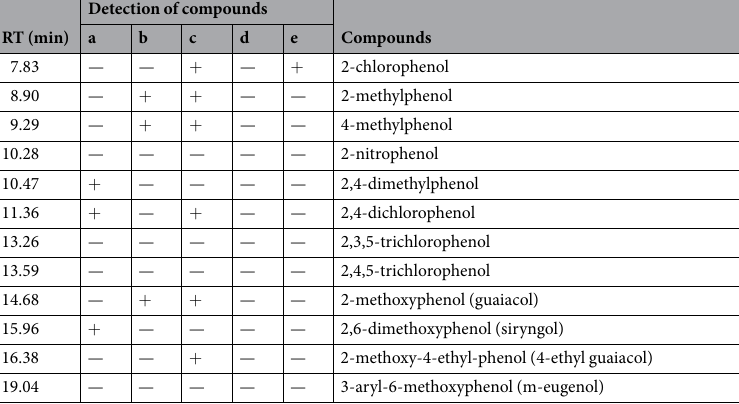
Table 2. Phenolic compounds identified by GC-MS in initial SBL and in samples post-treated with P. ostreatus and P. pastoris . The presence of chlorophenol could be related to the alkaline extraction process to obtain SBL. Under this condition, free aromatic rings were unstable and could be chlorinated by the presence of small quantities of Cl 2 in the water. Both fungi were able to biotransform chlorinated and non-chlorinated phenolic compounds, although the modifications by the native fungus and recombinant yeast were distinct. RT: Retention time (min); a : Initial phenol in SBL; b : SBL treated with P. ostreatus for 192 h; c : SBL treated with P. pastoris for 192 h; d : SBL treated with P. ostreatus and Cu/TiO 2 for 10 h; e : SBL treated with P. pastoris and CuTiO 2 for 10 h; + present; −